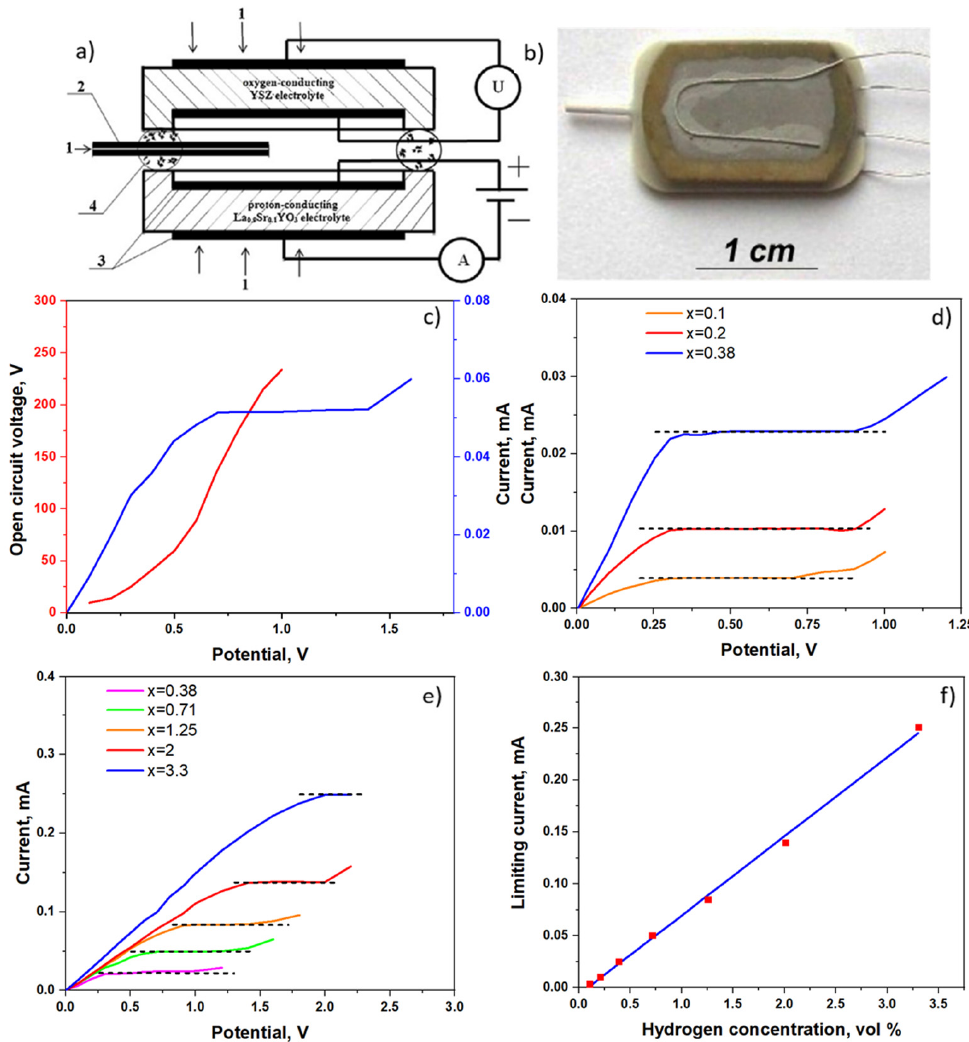
Figure 5. ( a ) The configuration of the amperometric H 2 sensor: (1) the analyzed gas, (2) ceramic capillary, (3) Pt electrodes, and (4) glass sealant; ( b ) photo of the fabricated sensor; ( c ) I and OCV related to the voltage for 0.7 vol.% H 2 + N 2 at the temperature of 550 °C ; ( d ) I-V curves for low hydrogen concentration (0.1–0.38 vol.% H 2 ) at 550 °C; ( e ) I-V curves for the hydrogen concentrations ranging from 0.38 to 3.3 vol.% H 2 in the H 2 + N 2 at 550 °C; ( f ) the limiting current plotted against the hydrogen concentration. (Data reproduced with permission from [47]. Copyright ©2014 Elsevier. All rights